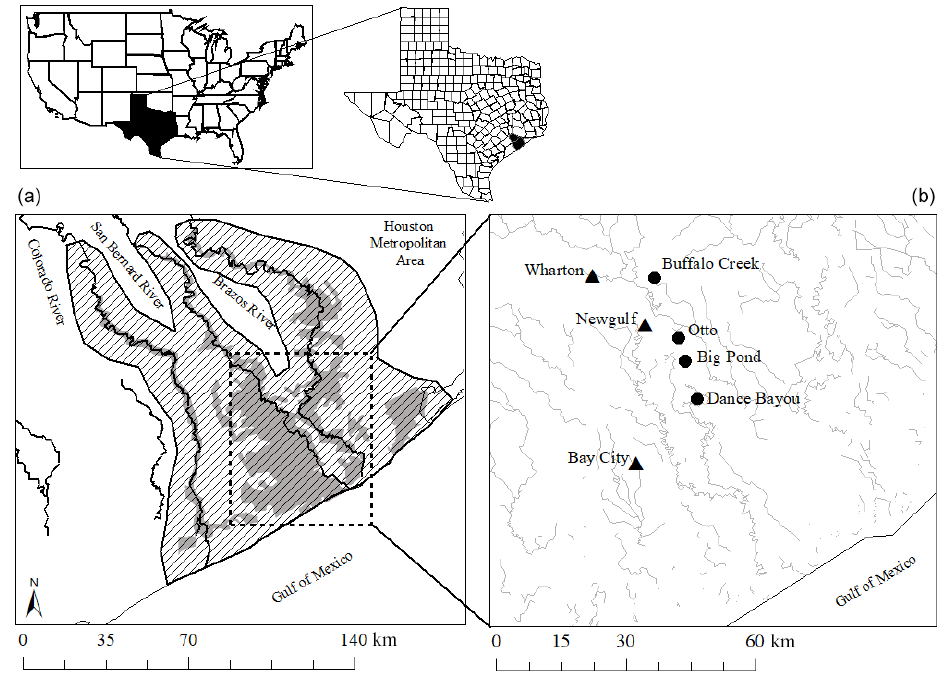
Figure 1. (a) Current distribution of the Columbia bottomlands (gray) and the historic extent shown by the slanted parallel lines (USFWS, 1997; Houston Wilderness, 2007; Rosen et al., 2008). The area in which the study sites are located is shown by the box with a dashed line. (b) Locations of study sites (circles) and weather stations (triangles) in the Brazos–Colorado coastal